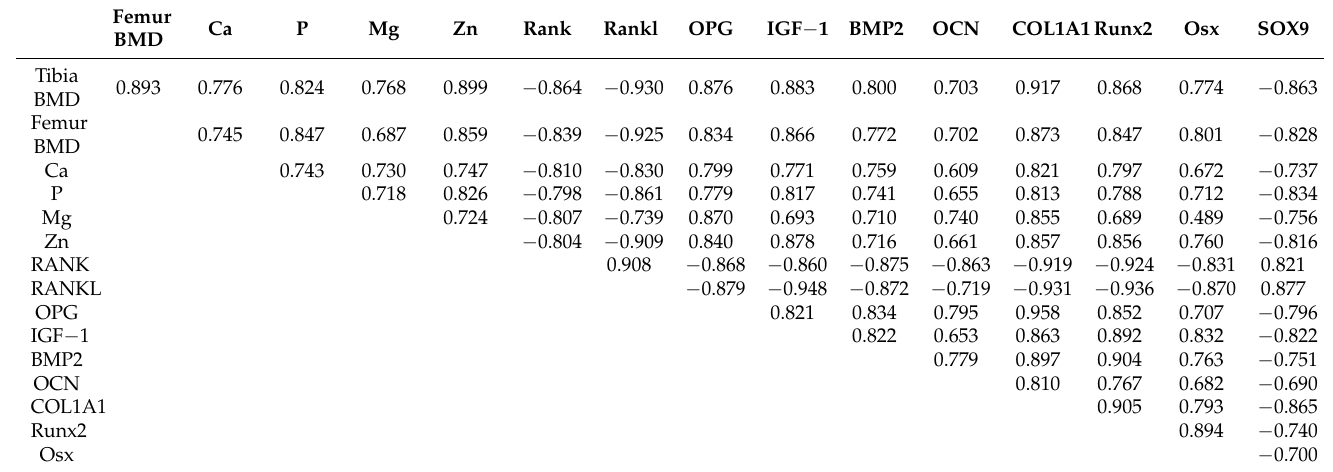
Table 5. The correlation between BMD, bone Ca, P, Mg, Zn, and target protein levels. Femur